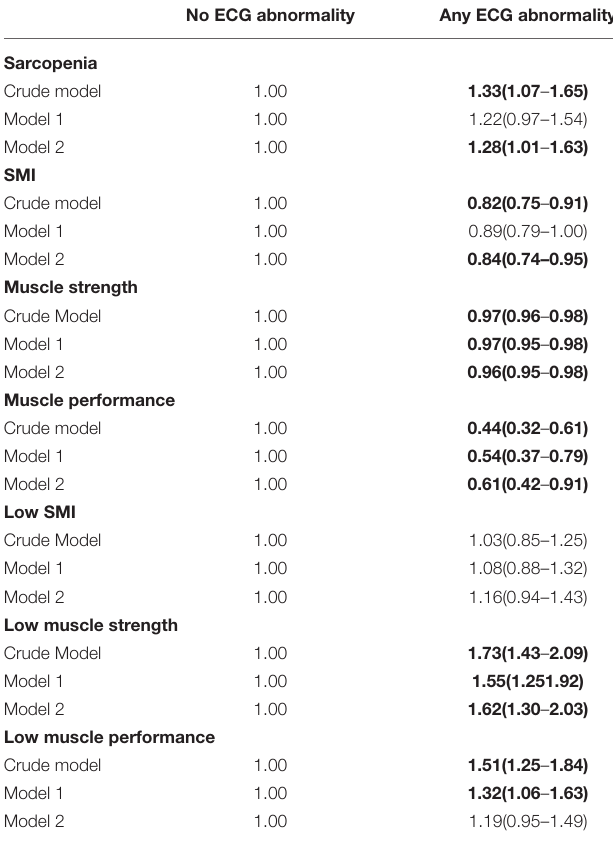
TABLE 2 | Association of sarcopenia and muscle components with minor and major ECG abnormalities.